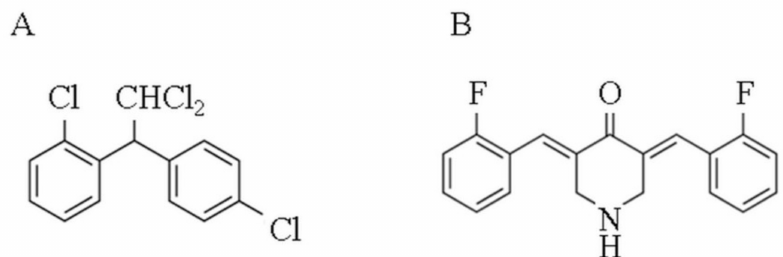
Figure 1. Chemical structure of the two compounds used in subsequent experiments. ( A ) mitotane (1-(2-Chlorophenyl)-1-(4-chlorophenyl)-2,2-dichloroethane,1-Chloro-2-[2,2-dichloro-1-(4-chlorophenyl) ethyl]-benzene); ( B ) and EF24